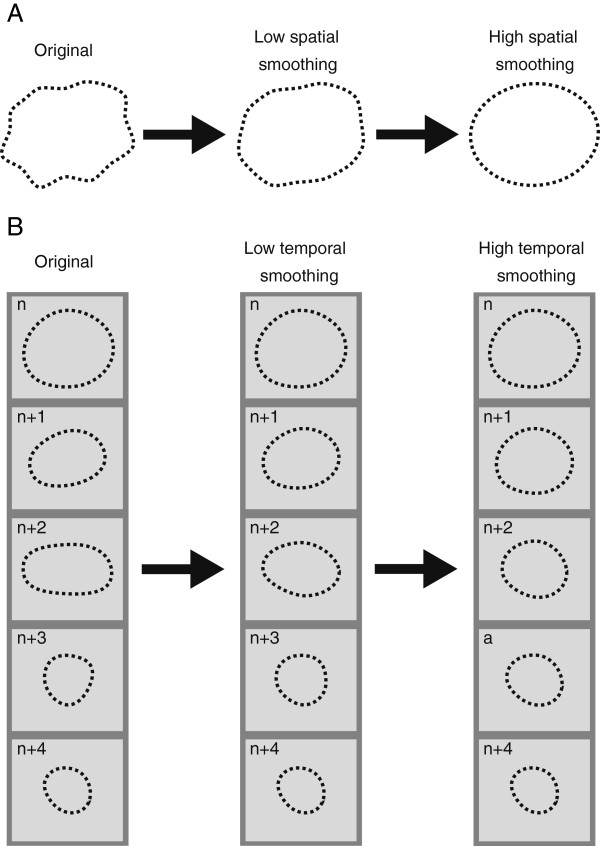
Illustration of (A) spatial and (B) temporal smoothing of a contour created by the points in the middle of the region of interest (ROI), as shown in Figure1A. To obtain a regularly moving ROI throughout the heart cycle, the smoothing procedure restricts the ROI from large or irregular movements from frame to frame. In (A), increasing the spatial smoothing will, for each separate frame of the heart cycle, reduce kinks or steps in the contour. With smooth contours at each frame, increasing the temporal smoothing will, on the other hand, enable a smooth transition between contours from frame to frame, as indicated in the rightmost column of (B). Arrows indicate increasing degree of smoothing.